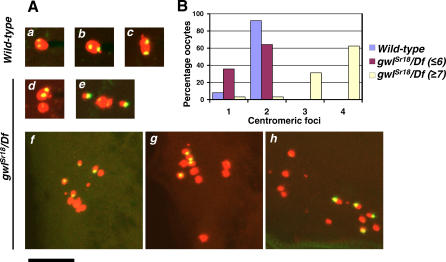
Gwl Is Required for Sister Chromatid Cohesion in Female Meiosis(A) Confocal images of meiotic figures of single oocytes stained for DNA (red) and showing FISH signal for satellite DNA near the centromere of the X chromosome (large green foci). In wild-type oocytes (a–c), one or two large foci are observed, representing the two homologous pairs of centromeres without tension in prophase (one focus) or under tension on the chiasmate bivalent in prometaphase or metaphase I (two foci). Up to four large foci are observed in gwlSr18/Df oocytes (d–h), indicating the absence of sister chromatid cohesion. Panels d and e show examples of figures with six or fewer DNA masses; panels f–h show examples of figures with more than six DNA masses. Scale bar is 10 μm.(B) Quantitation of the number of centromeric FISH foci relative to the number of DNA masses in wild-type and gwlSr18/Df oocytes (as in [A]). In gwlSr18/Df oocytes, the presence of more than two centromeric FISH signals strongly correlates with the presence of more than six large DNA masses, consistent with the loss of sister chromatid cohesion. Numbers of oocytes scored are 75 for wild type, 98 for gwlSr18/Df with six or fewer DNA masses, and 32 for gwlSr18/Df with seven or more DNA masses.